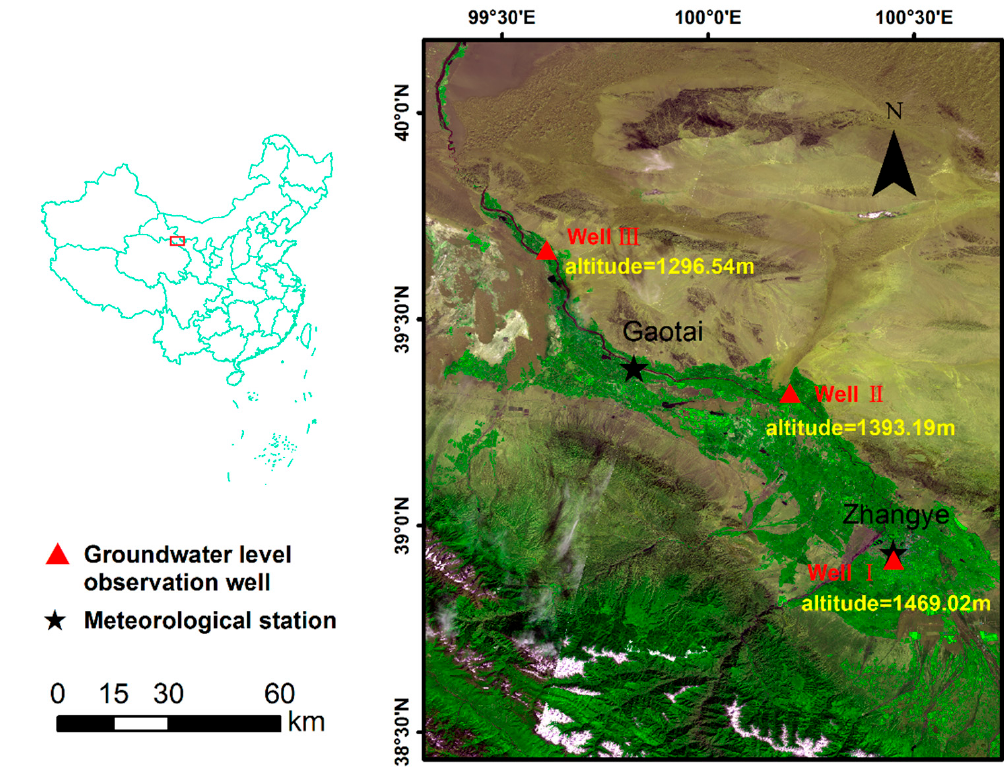
Figure 2. Location study area with the groundwater level observation well sites and meteorological sites.